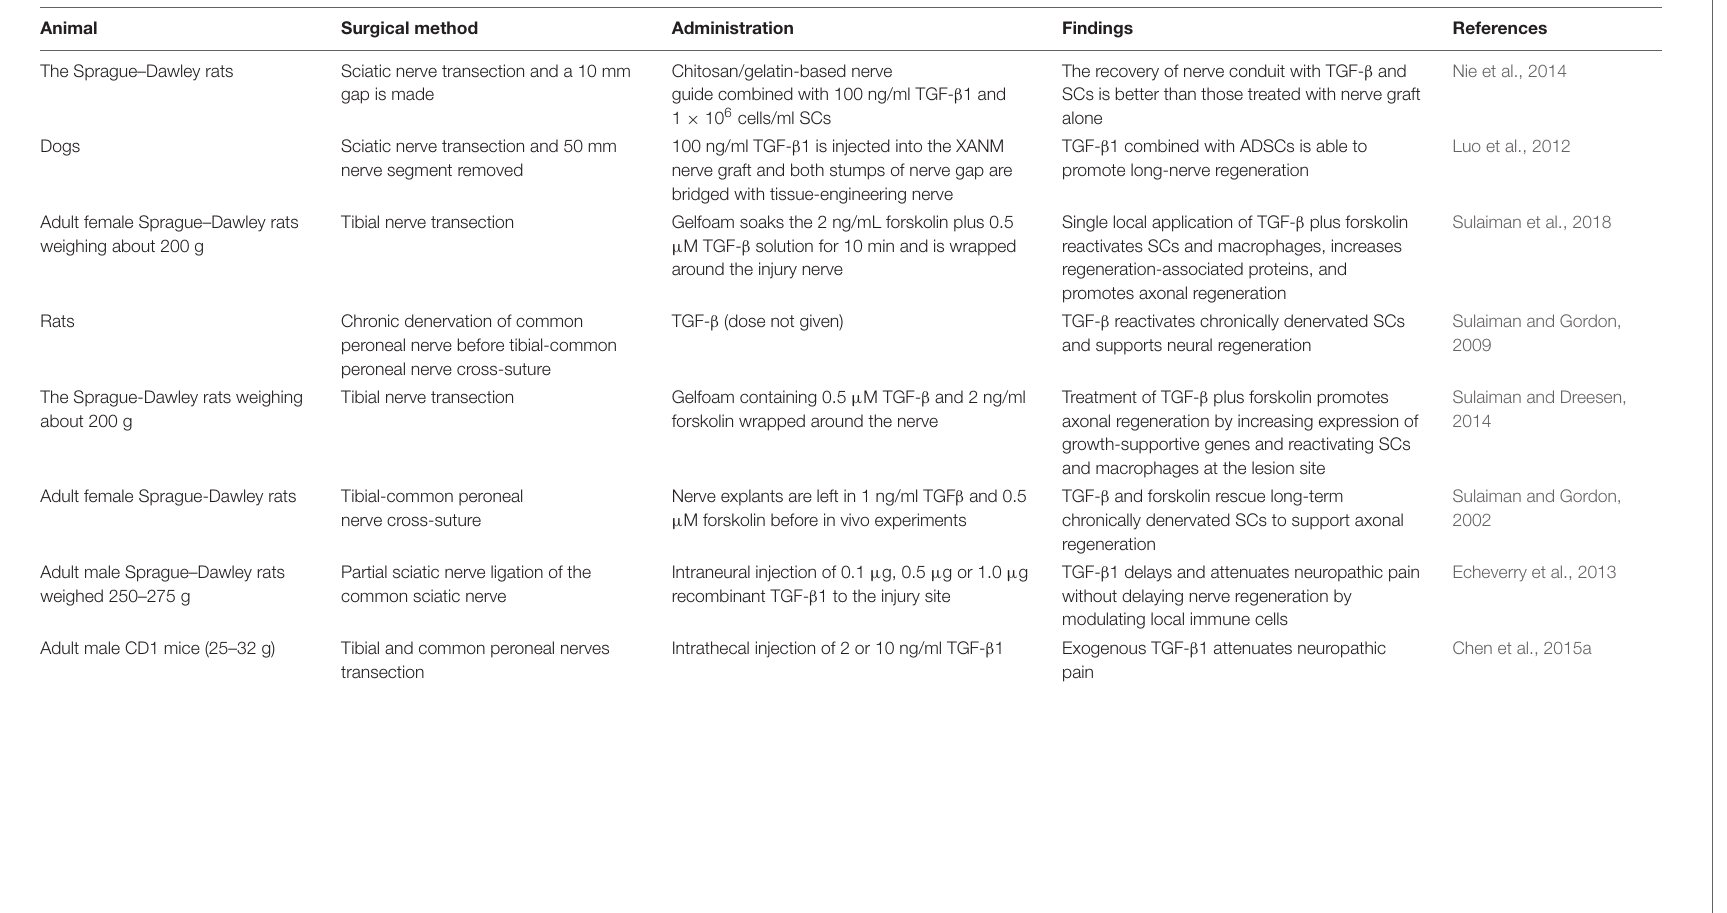
TABLE 1 | Findings of exogenous transforming growth factor-beta and its effects on nerve repair. Animal Surgical method Administration